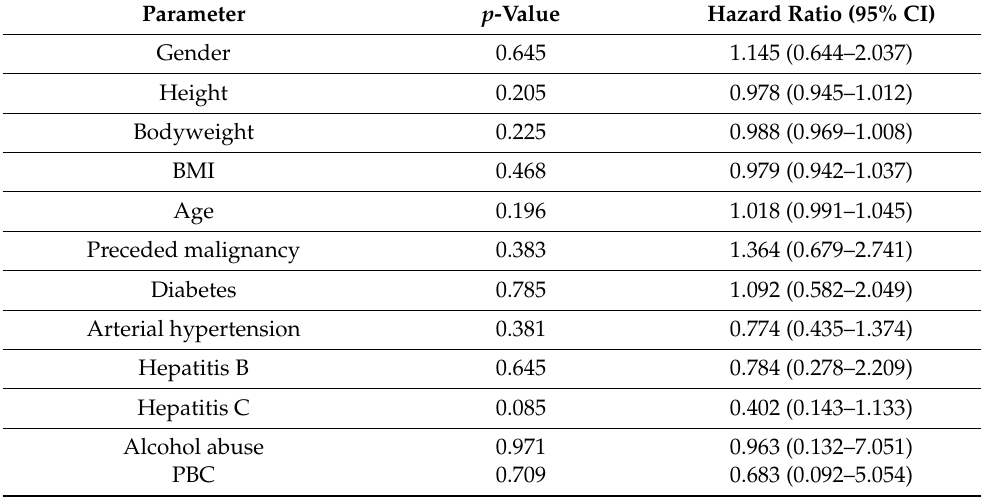
Table 2. Univariate Cox regression analysis for the prediction of overall